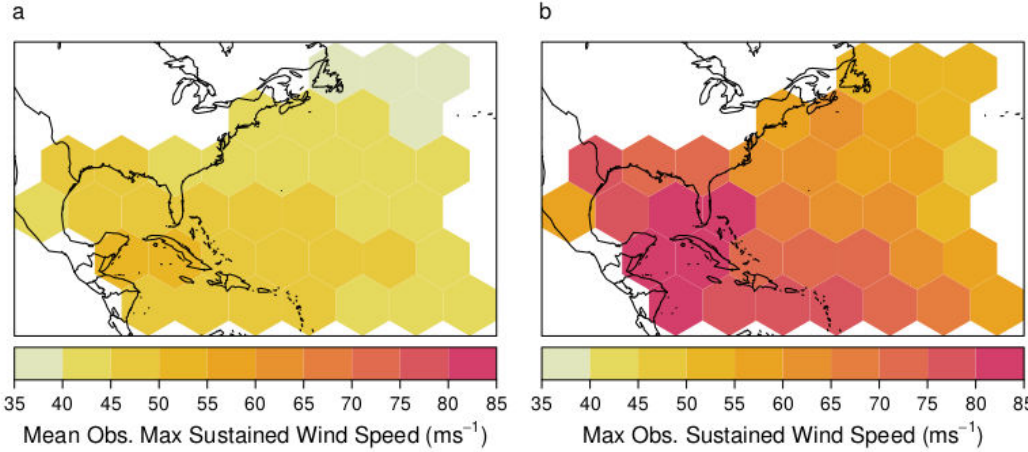
Figure 3. ( a ) Mean observed maximum sustained wind speeds per hexagon in ms − 1 . ( b ) Maximum observed sustained wind speeds per hexagon in ms − 1 . Note the identical scale between the